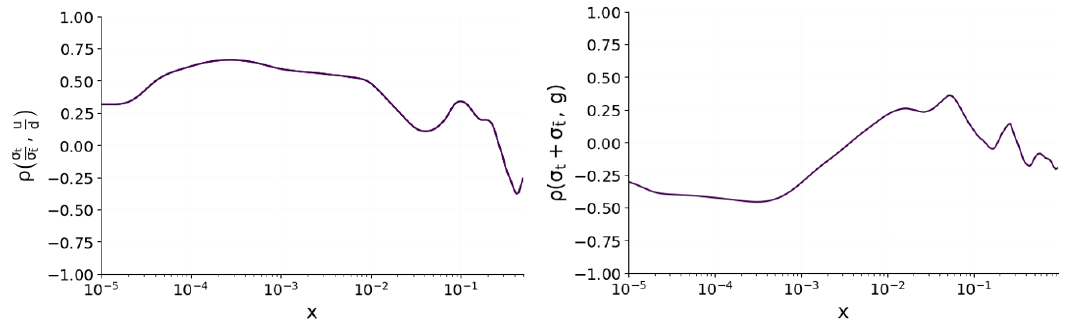
Figure 9 . Correlation coe(cid:14)cient (cid:26) between the up-quark/down-quark PDF ratio and the ATLAS measurement of (cid:27) t =(cid:27) at 13 TeV (left panel), and the gluon and the CMS measurement of (cid:27) t + (cid:27) t at 7 TeV (right panel). The correlation coe(cid:14)cient (cid:26) is computed using the NNPDF31 nnlo as 0118 PDF set at Q = m t = 172 : 5 GeV. Note that the x -axis in the left panel runs between x = 10 (cid:0) 5 and x = 0 : 5. This truncation of large values of x is due to the fact that as x ! 1, u=d ! 0 = 0, which leads to numerical instabilities in (cid:26)